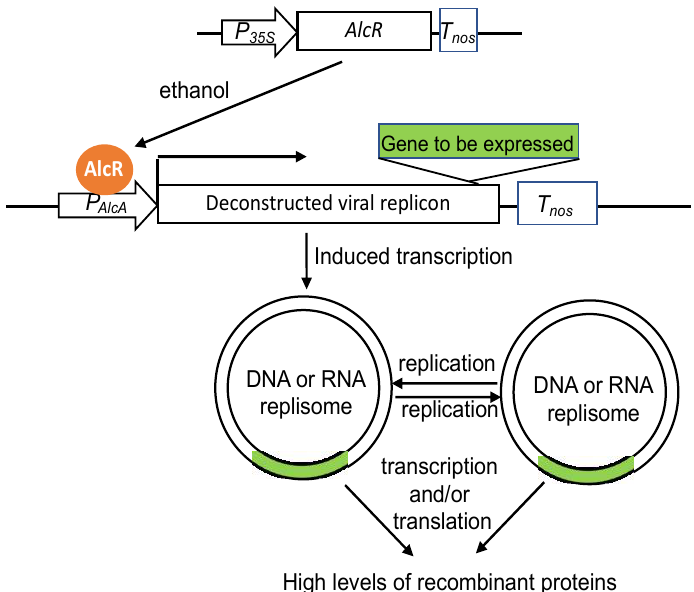
Figure 3. Inducible release of transgene-containing virus replicons for high level recombinant protein production in stable transgenic plants.